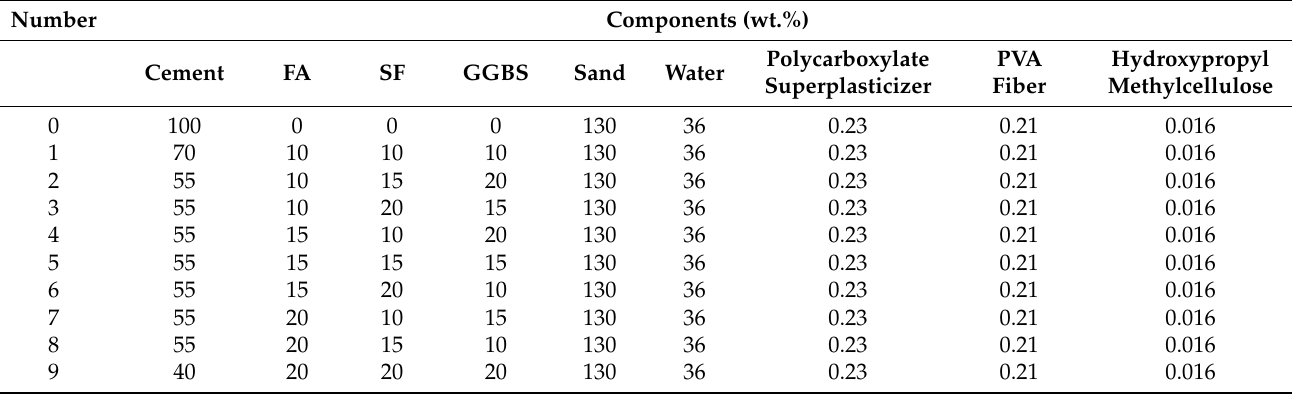
Table 3. Sample mix proportion of this